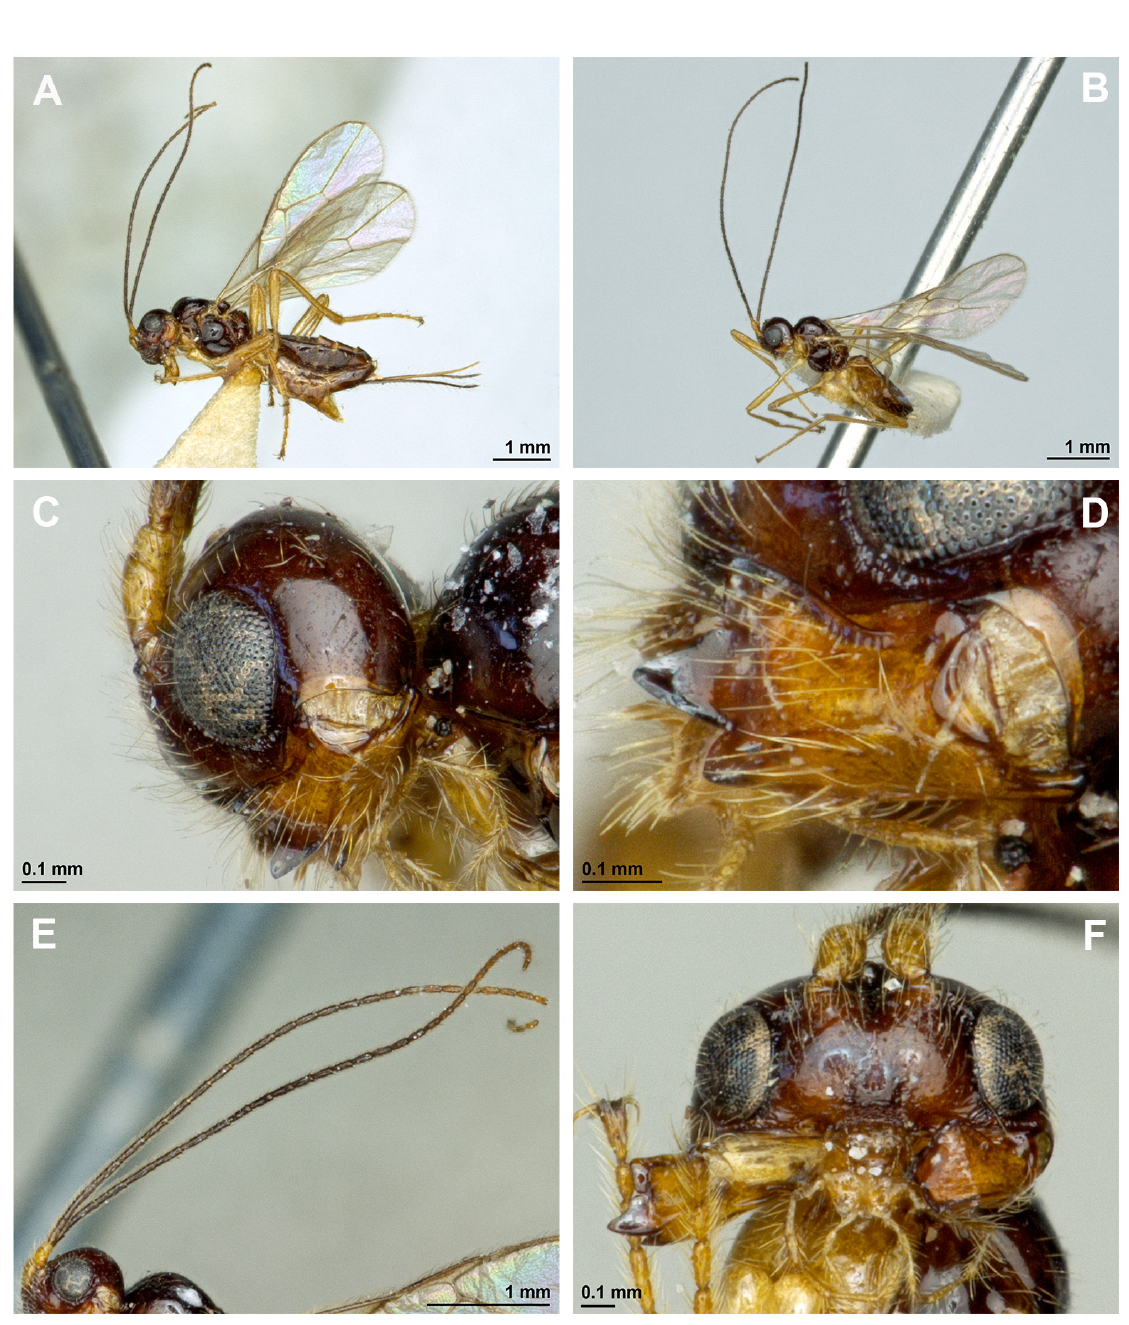
Fig. 56. Asobara somertensis Peris-Felipo, sp. nov., A, C–F: ♀, holotype (BMNH 1931-37); B: ♂ (BMHN). A–B . Habitus, lateral view. C . Head, lateral view. D . Mandible. E . Antenna. F . Head, front